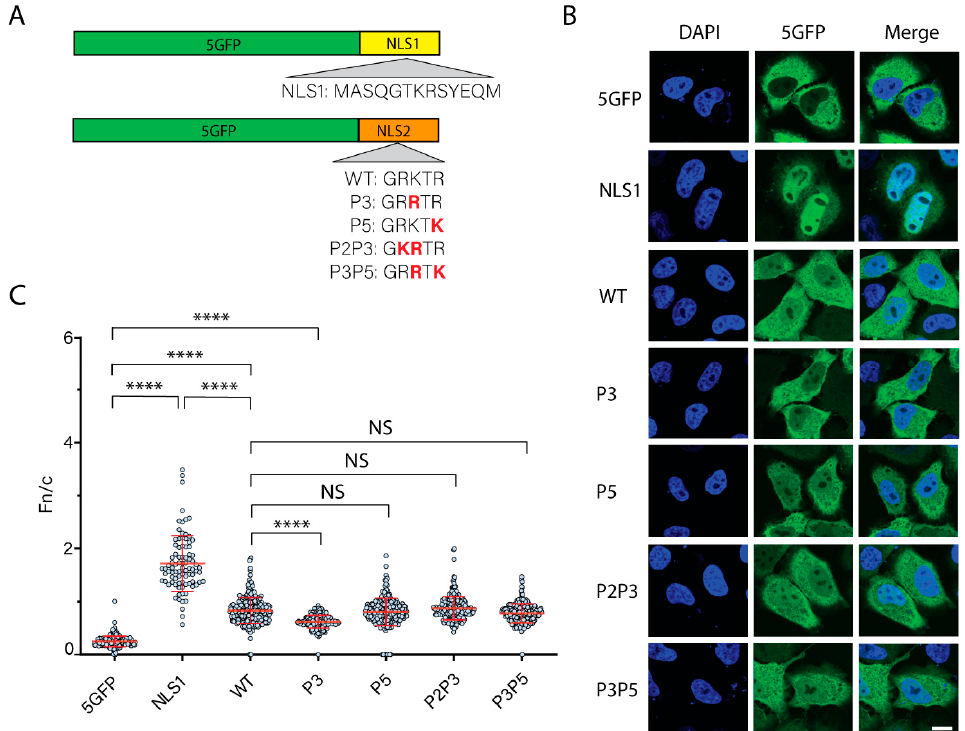
Figure 3. Functional analysis of NLS2 variants naturally found in NP of different influenza A virus strains. ( A ) Schematic representation of the chimeric proteins containing NLS1 and NLS2 variants fused to the C-terminus of 5GFP. The amino acids in red indicate substitutions from the WT NLS2 sequence. ( B ) Confocal images of HeLa cells transfected with plasmids expressing 5GFP, 5GFP-NLS1, or five NLS2 variants fused to 5GFP 24 h post-transfection. Nuclei were stained with DAPI. Scale bar, 10 μ m. ( C ) Quantification of the ratio of nuclear to cytoplasmic fluorescence (Fn/c) from the experimental conditions shown in B. Shown is the means ± standard error of the means scored from 85–100 cells for each condition from three independent experiments. (NS, not significant; **** p < 0.0001, one-way ANOVA followed by Tukey’s tests).